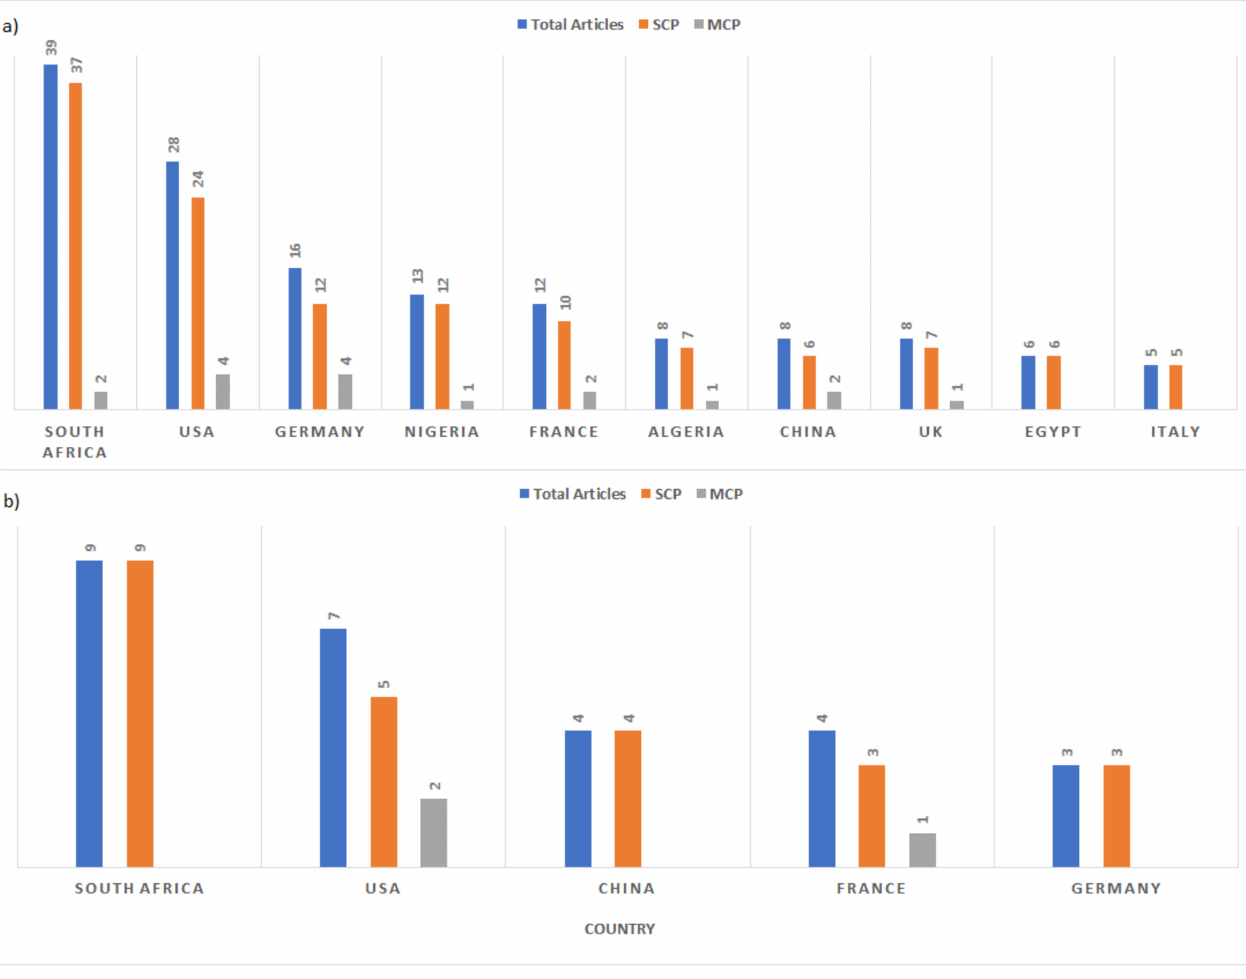
Figure 2. The top ( a ) ten (10) and ( b ) five (5) countries with a high number of published documents in Africa and southern Africa, respectively. The countries are ranked based on the corresponding author’s affiliated country. SCP—Single-Country Publication and MCP—Multi-Country